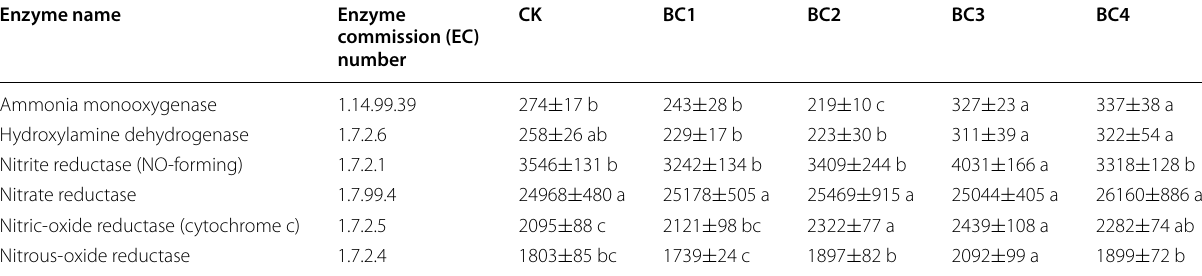
Values are mean plus standard deviation ( n 3), and data with different lowercase letters are significantly different at p < 0.05 according to Duncan’s multiple range = test. Treatments CK, BC1, BC2, BC3, and BC4 had biochar dosages of 0%, 0.5%, 1%, 2%, and